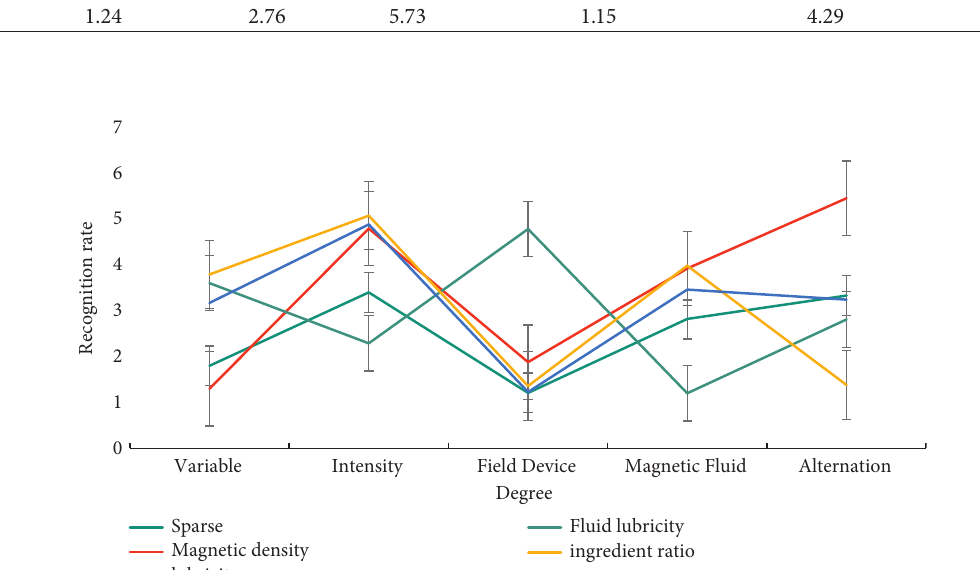
Figure 8: Thermoelastic hydrodynamic lubrication model